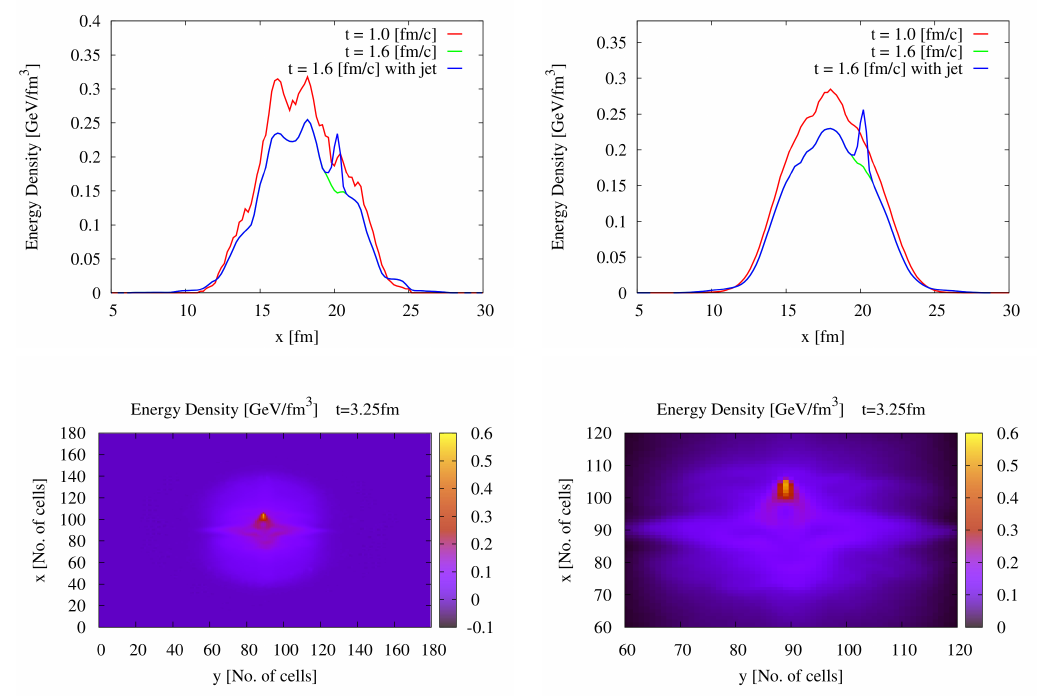
Figure 1. Energy density projection in 1D ( y = z = 0) of Au+Au at 200 GeV/c UrQMD initial conditions - red lines. Hydrodynamic simulations with jet - blue lines, without jet - green lines ( top panels ). Initial condition from UrQMD averaging over 10 events ( top left panel ) and 500 events ( top right panel ). Energy density cross-section of Au+Au at 200 GeV/c in 2D ( xy plane with z = 0 and cell size is ∆ x = ∆ y = ∆ z = 0.166 [fm] ) ( bottom left panel ). Energy density profile zoom × 3 ( bottom right panel